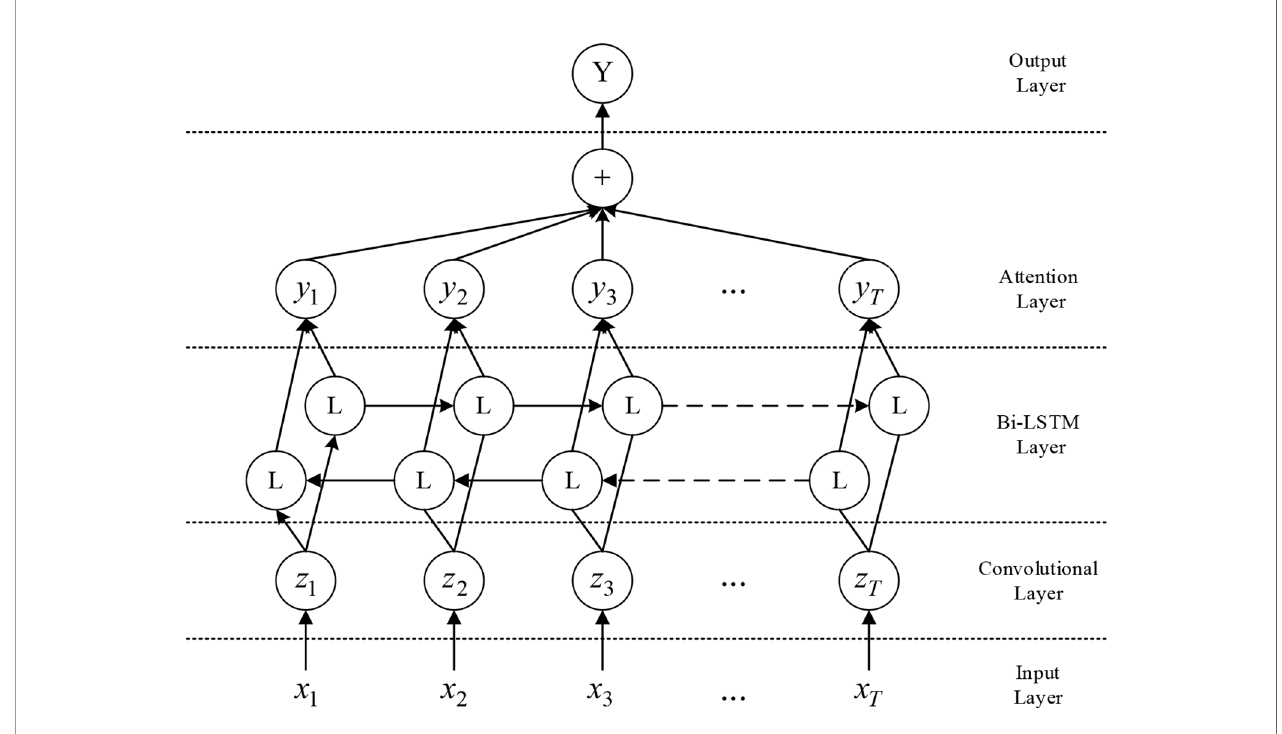
FIGURE 1 | CBA-Net model